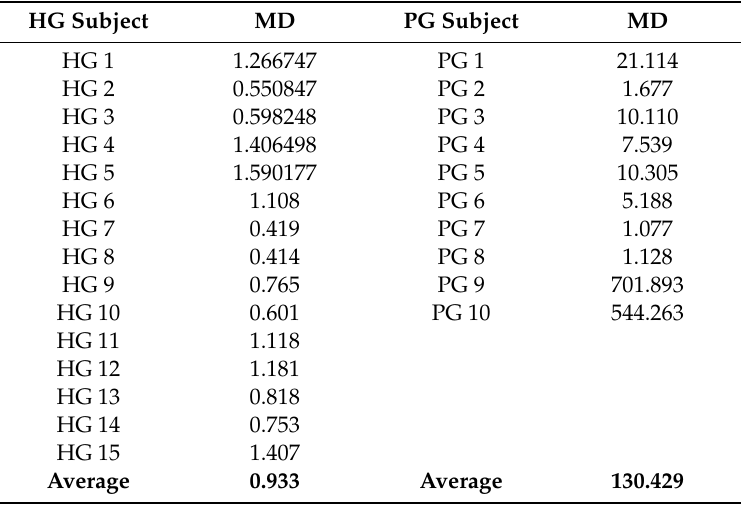
Table 10. MDs Value after recalculation using only the useful